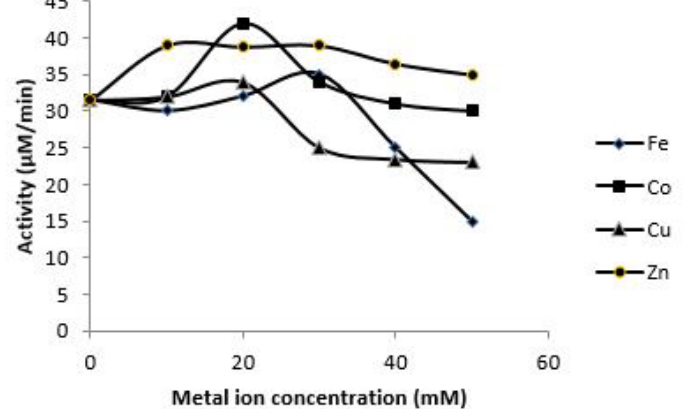
Figure 7: The effect of increasing concentrations of metal ions on C. lanatus rind invertase activity.